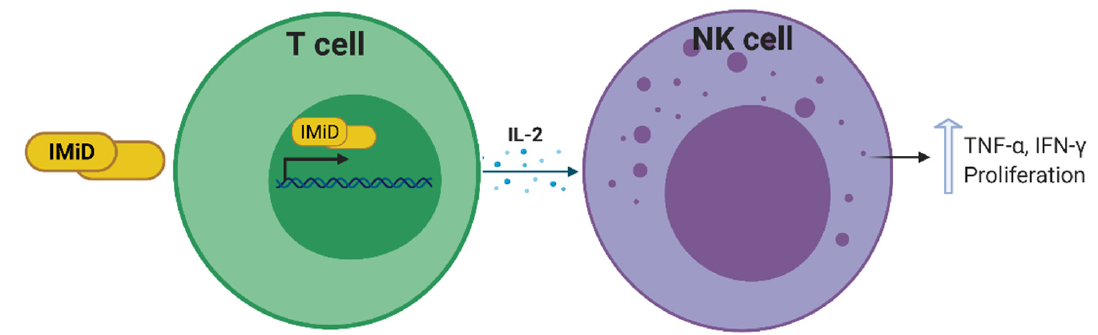
Figure 4. IMiDs mediate indirect augmentation of NK cell function. IMiDs act on IL-2 transcription in T cells to induce the production of TNF- α and IFN- γ and the proliferation of NK cells. Abbreviations: IFN- γ , interferon- γ ; IMiD, immunomodulatory imide drugs; IL-2, interleukin-2; TNF- α , tumor necrosis factor- α .